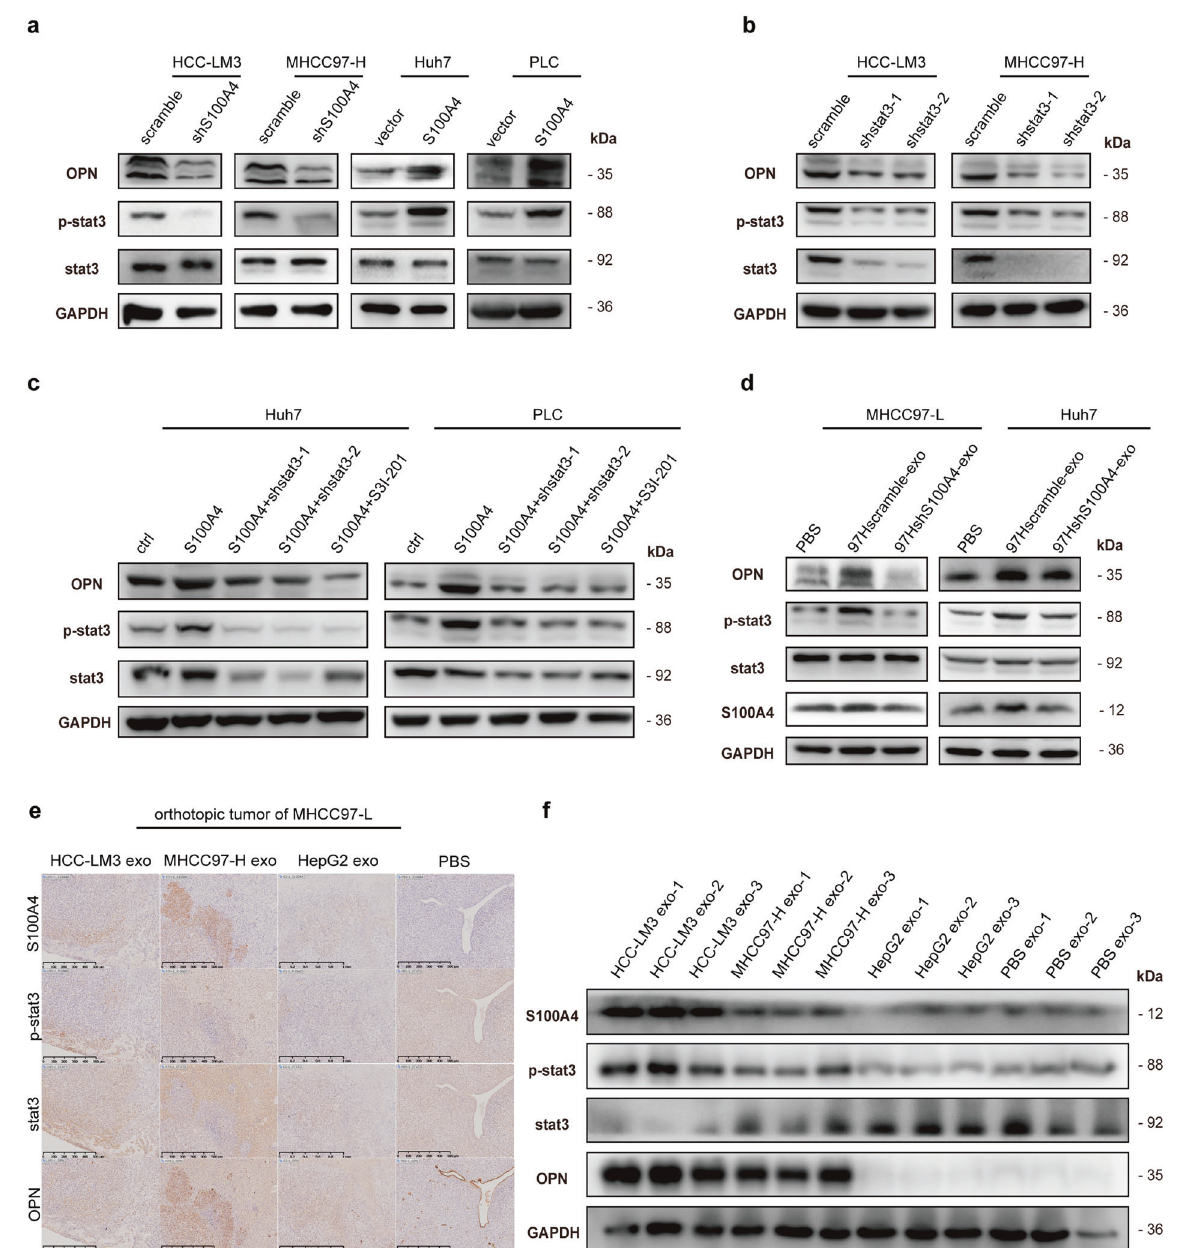
Fig. 5 Exosomal S100A4 activates OPN transcription via stat3 phosphorylation. a Western blot indicated that OPN and stat3 phosphorylation (p-stat3) levels follow the change of S100A4 level, while stat3 level maintains stable. b Western blot showed that knockdown of stat3 expression in high metastatic cell lines (HCC-LM3 and MCC97-H) spontaneously inhibits p-stat3 and OPN expressions. c Overexpression of stat3 in low metastatic cell lines (Huh7 and PLC) enhanced p-stat3 and OPN level, while such effect alleviated by stat3 knock down or stat3 inhibitor S3I-201, suggesting a relative up-stream regulation of p-stat3 to OPN. d Western blot showed that stat3 phosphorylation and OPN are signi fi cantly enhanced after S100A4 rich exosomes (97Hshscramble-exo) treatment. e , f Immunohistochemical staining and Western blot quanti fi cation of orthotopic tumors from mice showed that HMH exosomes (HCC-LM3 exosomes and MHCC97-H exosomes) promote stat3 phosphorylation and OPN expression in tumor tissue compared to PBS and LMH exosomes (HepG2 exosomes). Western blot was conducted three times